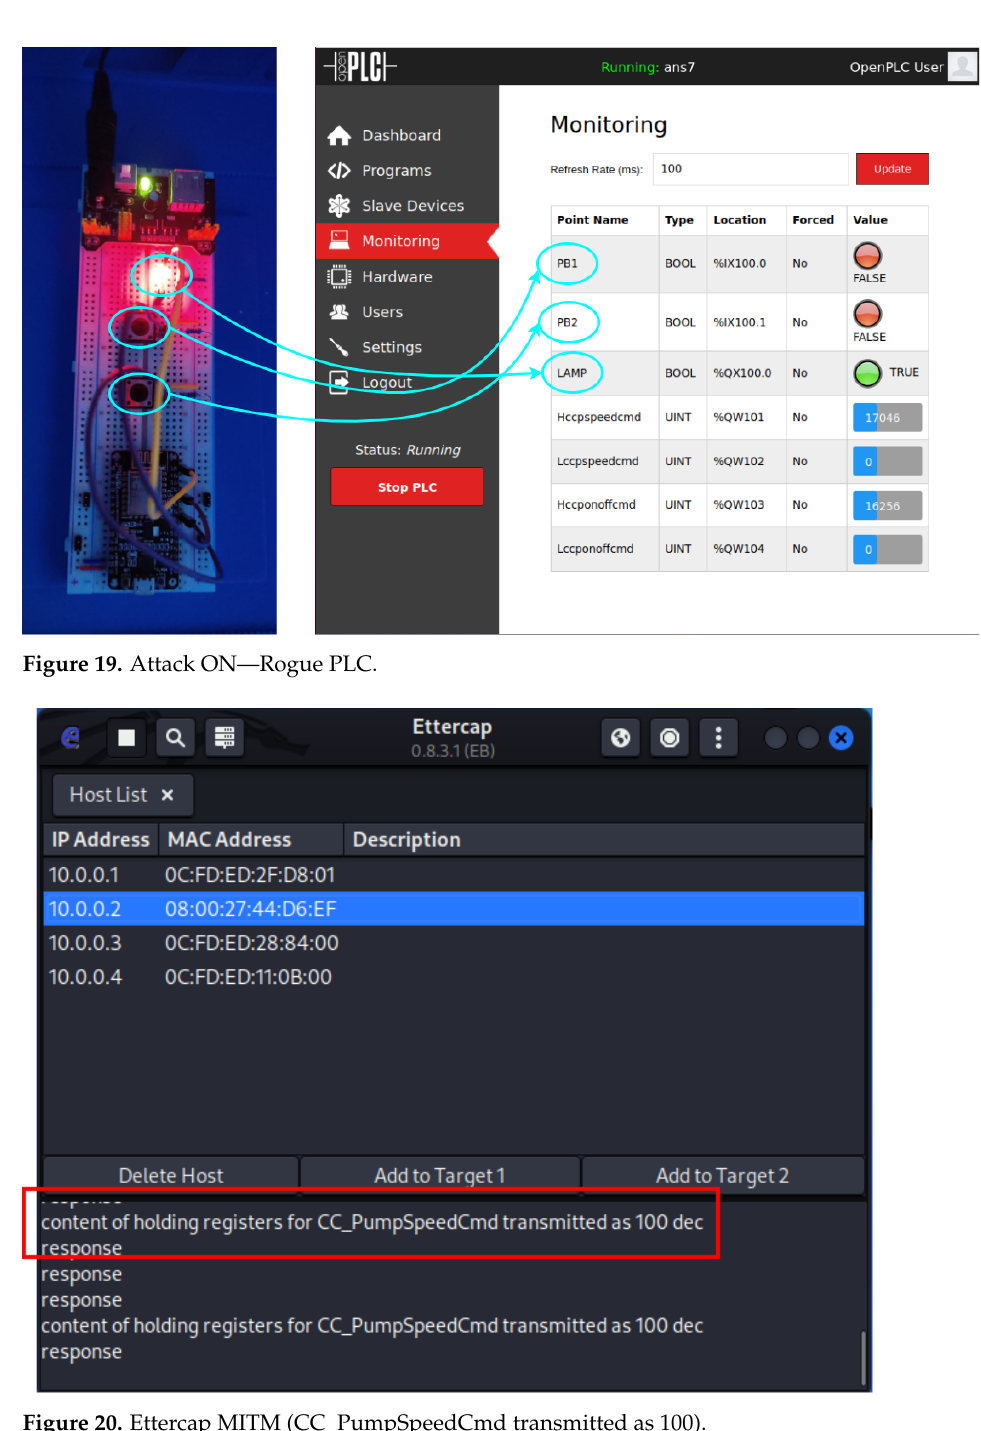
Figure 20. Ettercap MITM (CC_PumpSpeedCmd transmitted as